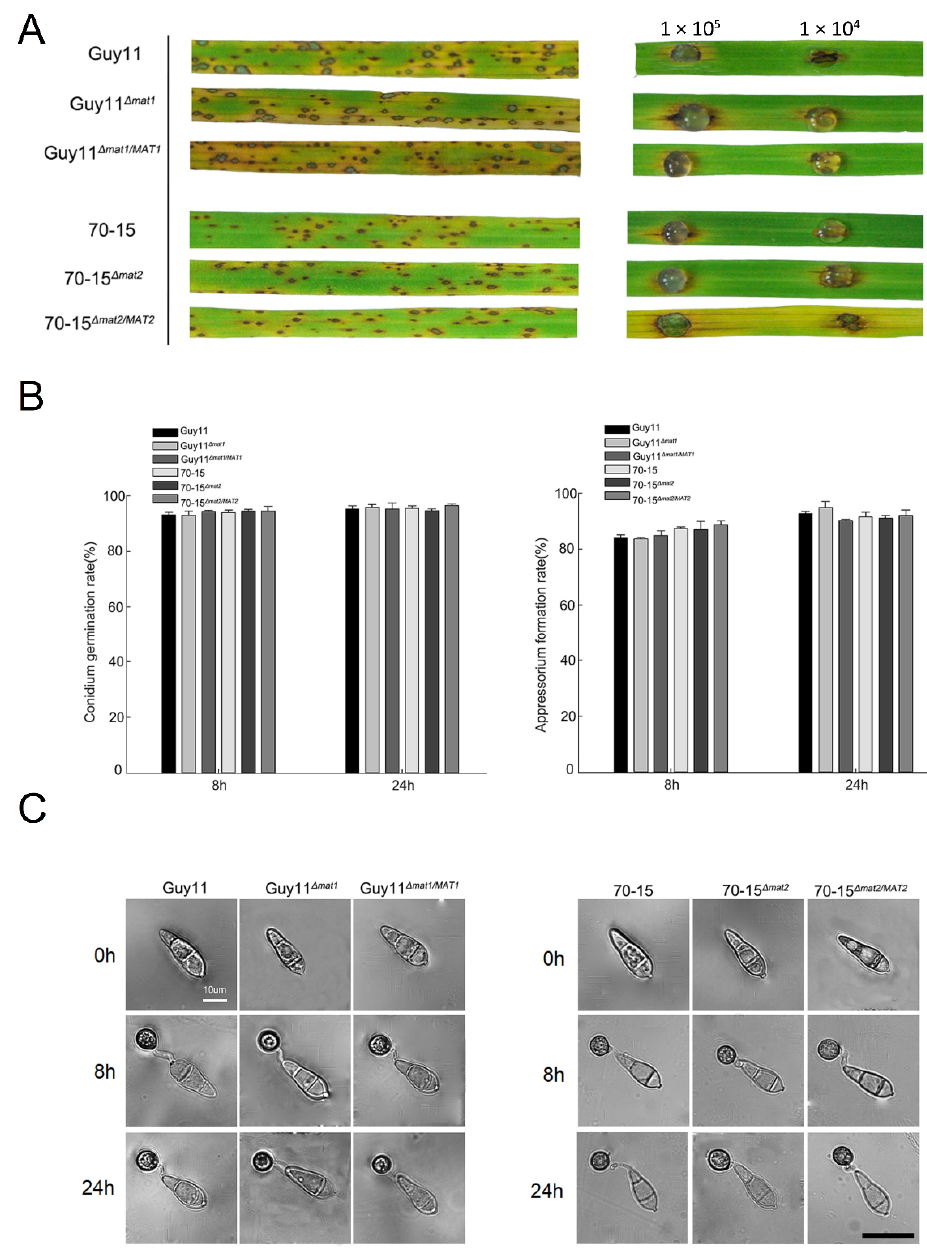
Figure 7. The pathogenicity and infection-related morphology were unaltered in MAT loci mutants. ( A ) The 2-week-old rice seedlings ( left ) were spray inoculated with the conidial suspensions at 1 × 10 5 conidia/mL for Guy11 and Guy11-derived strains and 5 × 10 4 conidia/mL for 70-15 and 70-15- derived strains; the detached rice leaves (right) were drop inoculated with the conidial suspensions at 1 × 10 5 conidia/mL and 1 × 10 4 conidia/mL. The symptoms were observed at 7 days post-inoculation. ( B ) The conidia of the strains were incubated on hydrophobic membranes to allow gemination and appressorium formation. The conidial germination rates (left) and appressorium formation rates (right) were calculated and compared at 0, 8 and 24 hpi (hours post-incubation). Mean and standard error were calculated from three independent biological replicates. ( C ) the morphology of the conidia and appressoria of the strains at 0, 8 and 24 hpi.